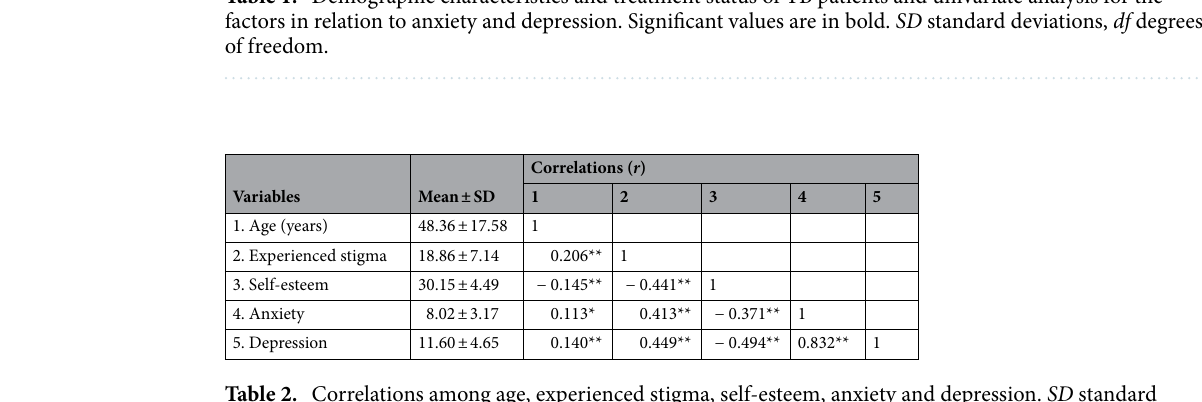
Table 2. Correlations among age, experienced stigma, self-esteem, anxiety and depression. SD standard deviations. * P < 0.05. ** P < 0.01